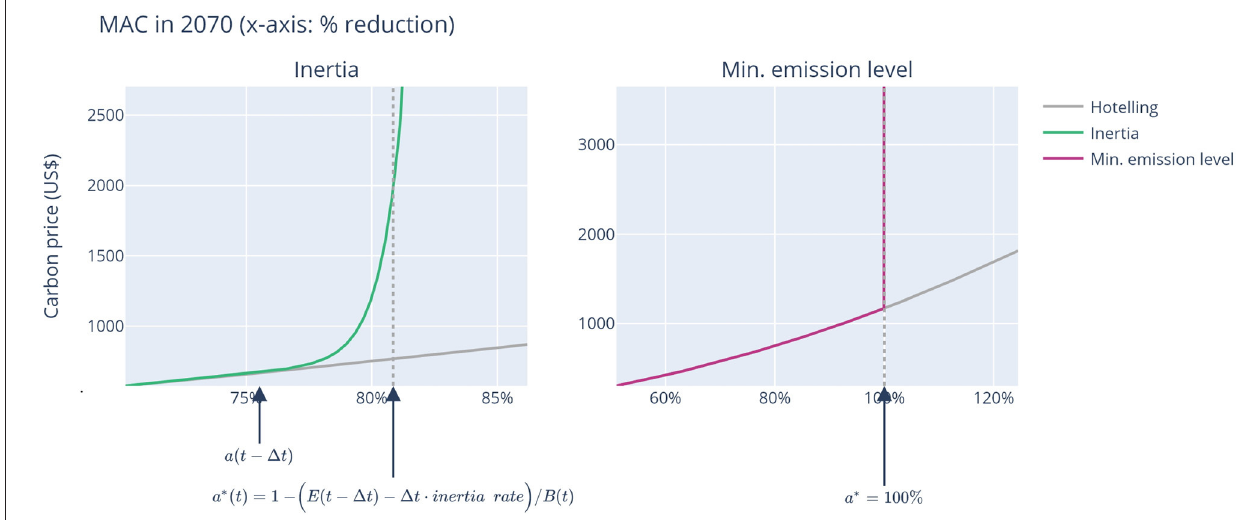
FIGURE 1 | Example of the MAC curve of the socio-economic inertia and minimum emission level experiments.